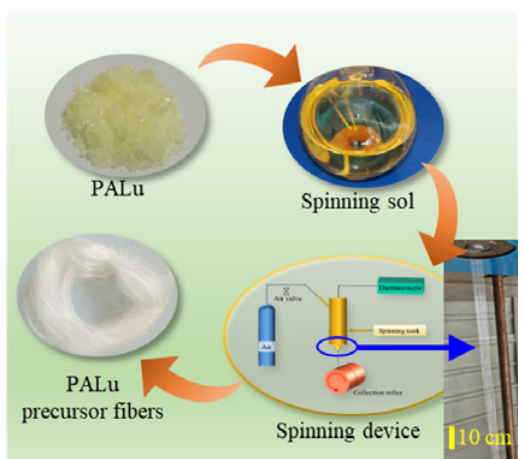
Fig. 1 Fabrication process of PALu precursor